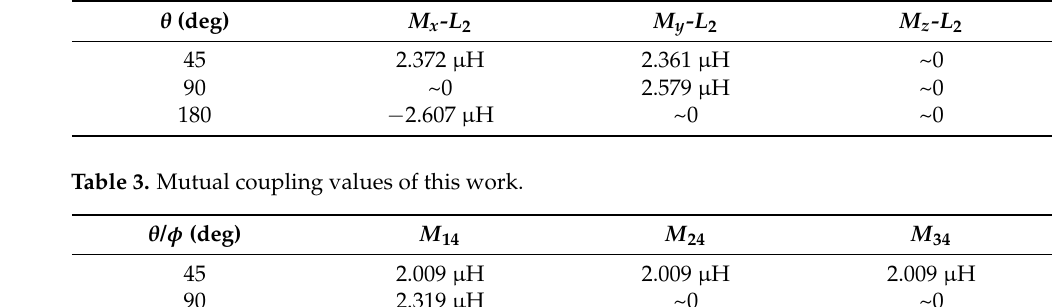
Table 2. Mutual coupling values Ref. [16].